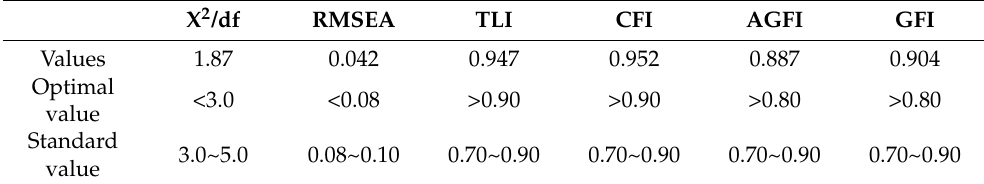
Table 3. Results of assessing alternative models.